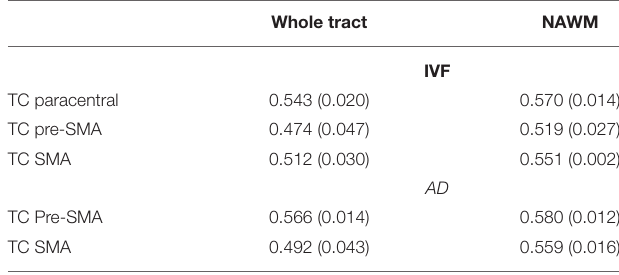
TABLE 3 | Significant correlations between IVF / AD and EDSS score. Whole